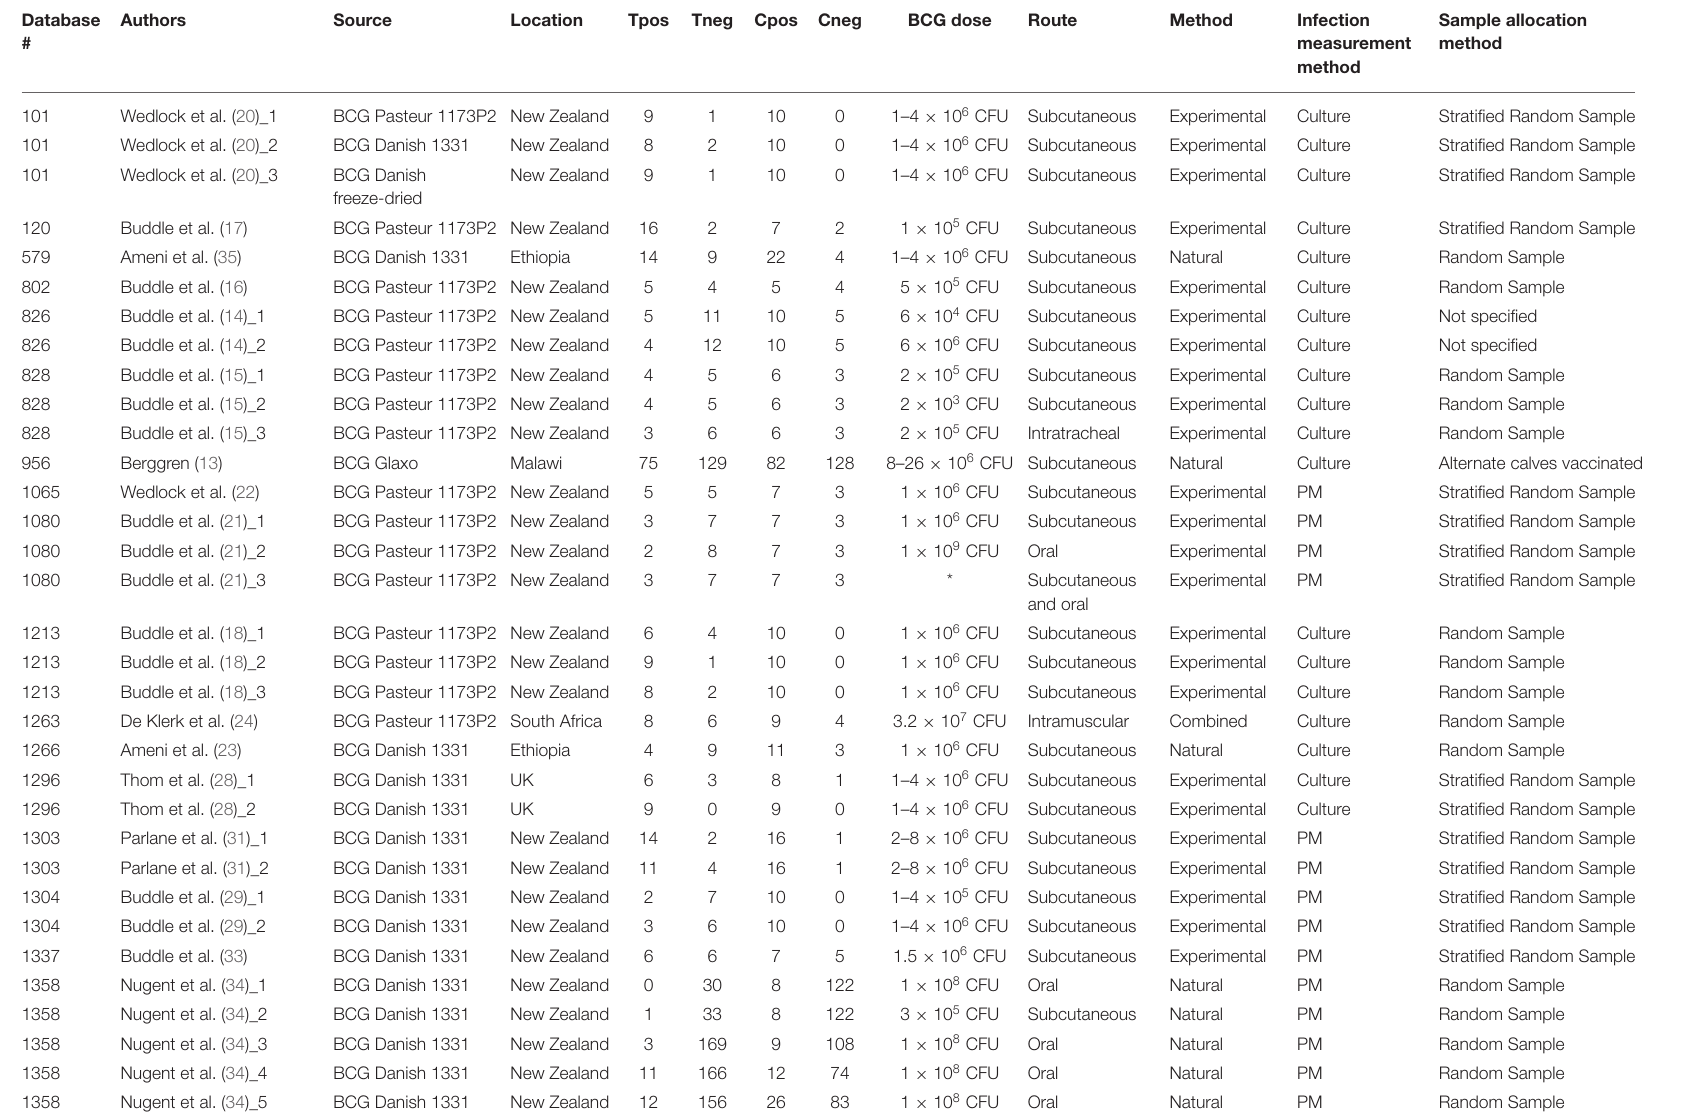
TABLE 1 | List of strata-level data ( n = 49) extracted from a total of 24 publications for inclusion in our